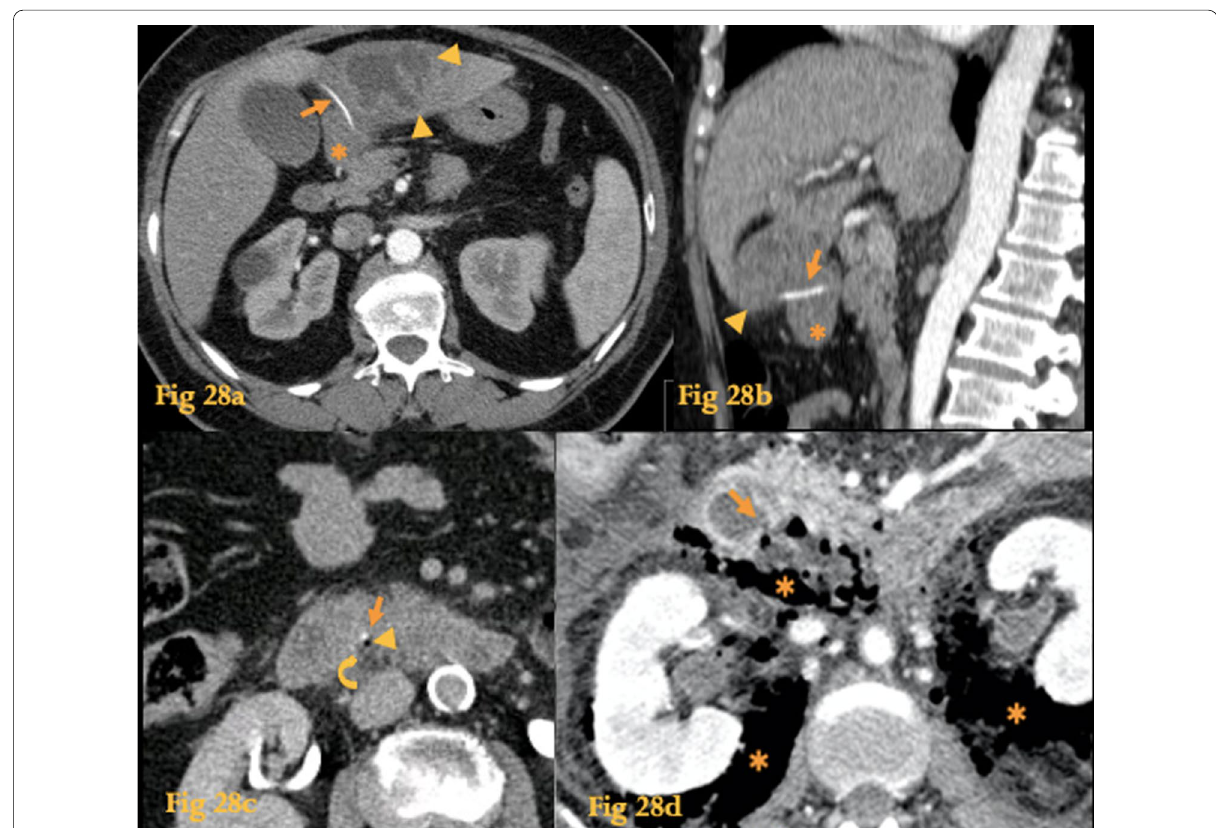
Fig. 28 Rupture. Abdominal CT ( a , b ) of a patient who had ingested a fishbone (arrow). It perforated the duodenal bulb (asterisk) and lodged on the left lobe of the liver. Note the adjacent liver abscess (arrowheads) that formed as a result. CT of another patient ( c ) shows an endoluminal calcic density structure—fishbone (arrow) at D3, with a small amount of adjacent extraluminal gas (arrowhead) and fat stranding (curved arrow), indicative of retroperitoneal rupture. CT of yet another patient who had underwent ERCP ( d ) shows a discontinuity of the posterior wall of D3 (arrow) and extensive pneumoretroperitoneum